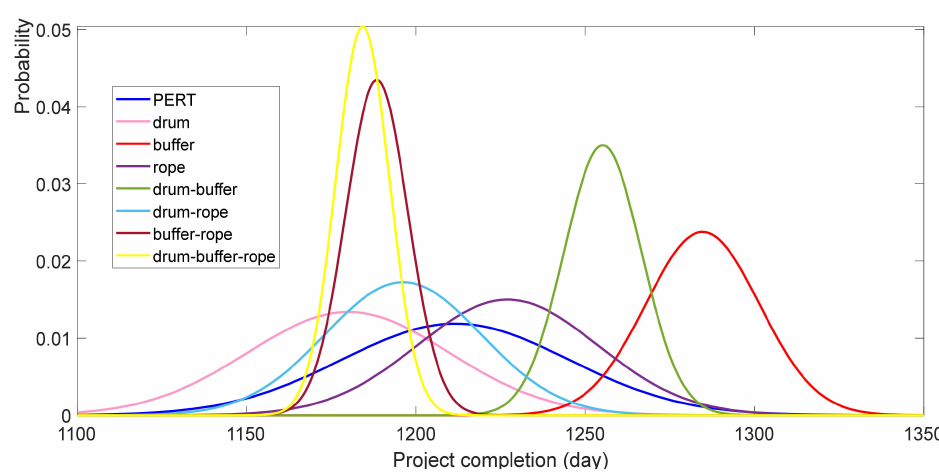
Figure 5. Simulation comparison of completion period distributions between different